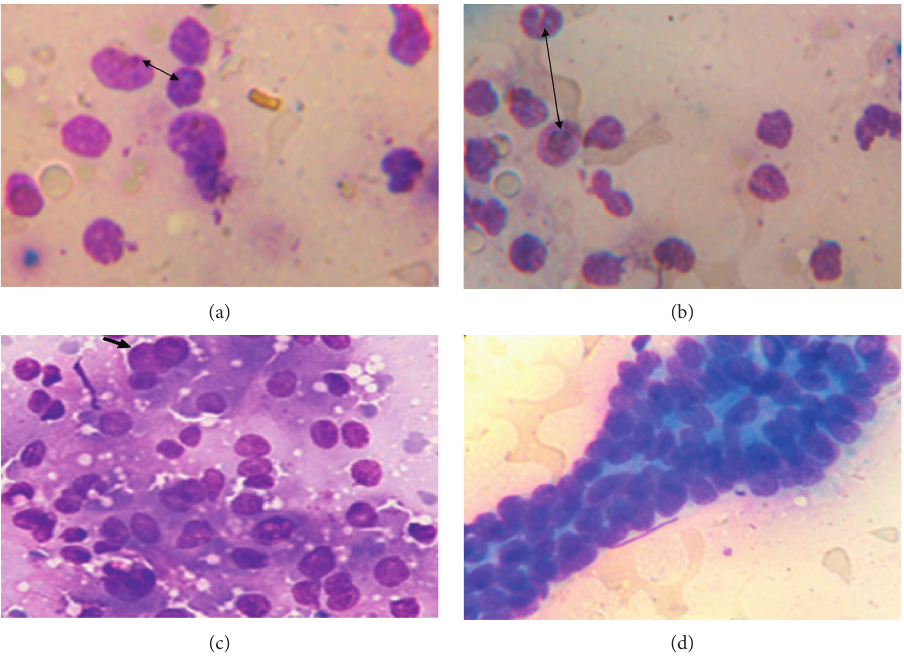
Figure 3: Cytological features of hepatocellular carcinomas in a